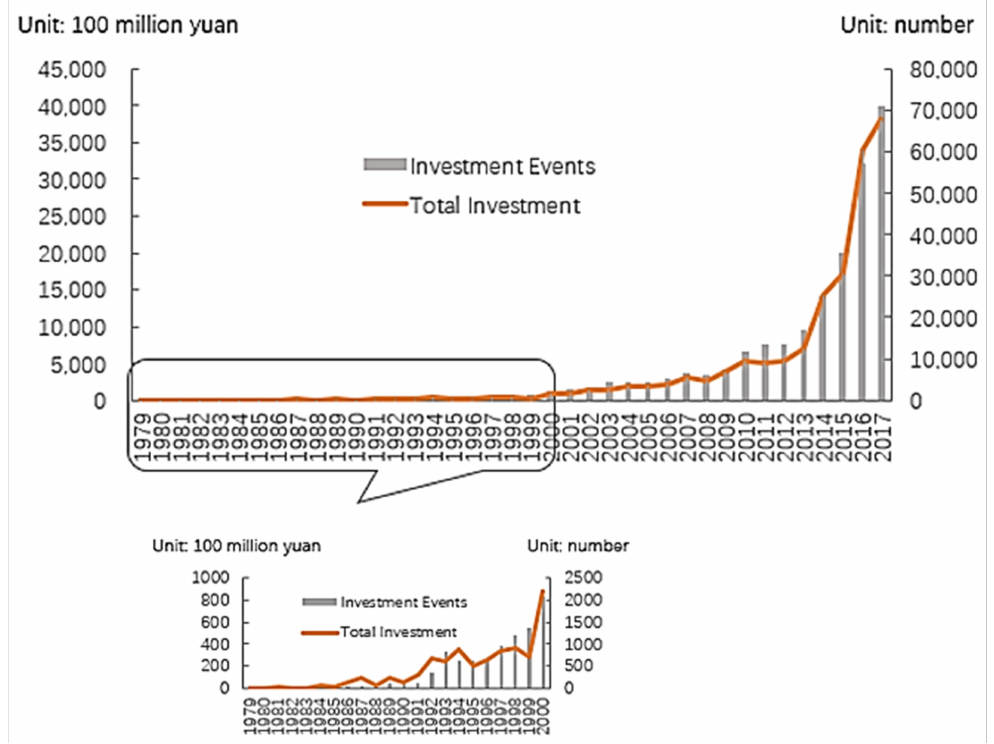
Figure 3. Chinese inter-city investment from 1979 to